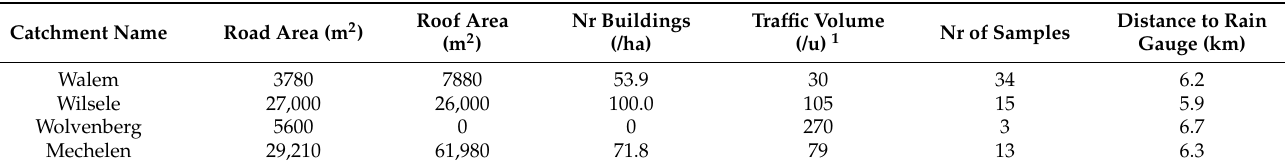
Table 1. Details of the catchments.